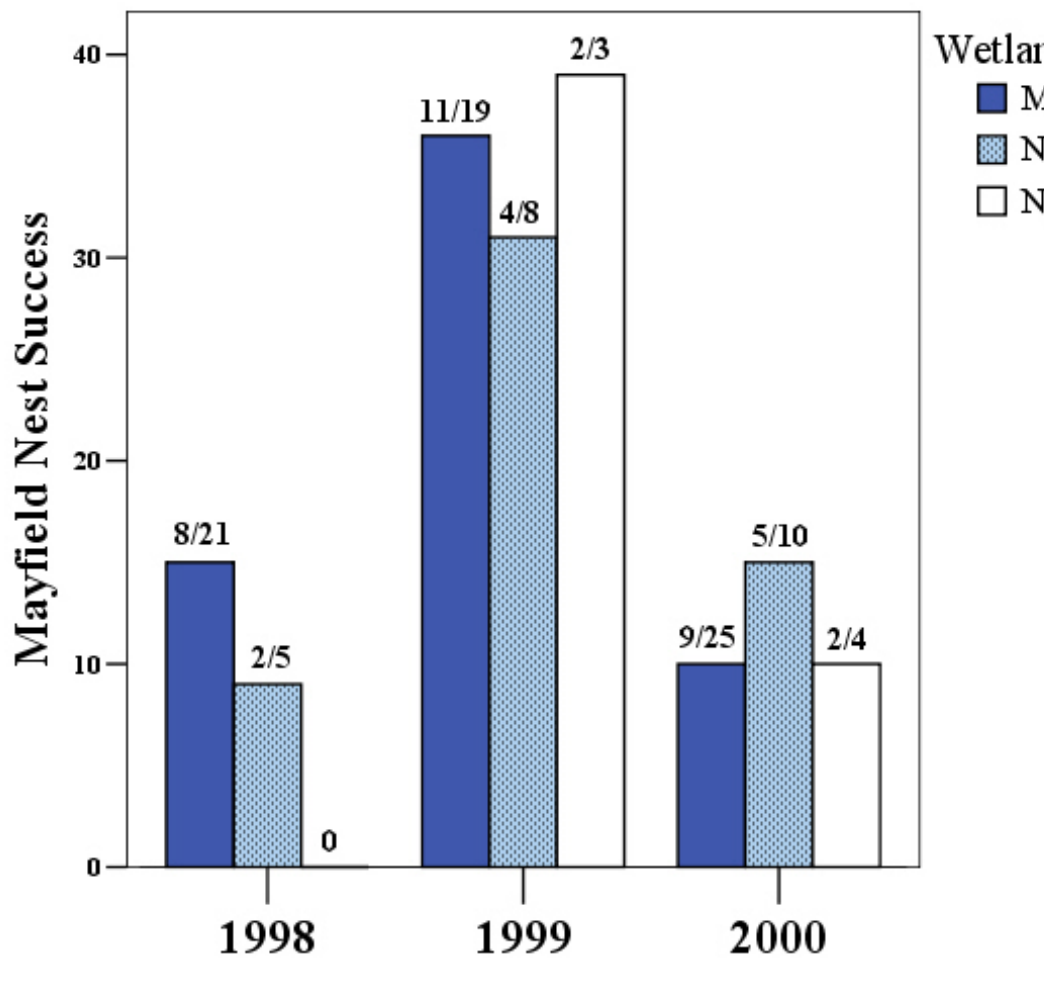
Fig. 3. Shorebird (marbled godwits, willets, and long-billed curlews combined) Mayfield nest success in survey areas with managed, natural, and no wetland basins from 1998 to 2000 in southeastern Alberta. Numbers above bars refer to the fraction of nests hatched of the total nests found. Sample sizes are too small for statistical analysis (the 95% confidence intervals on the Mayfield estimates were as